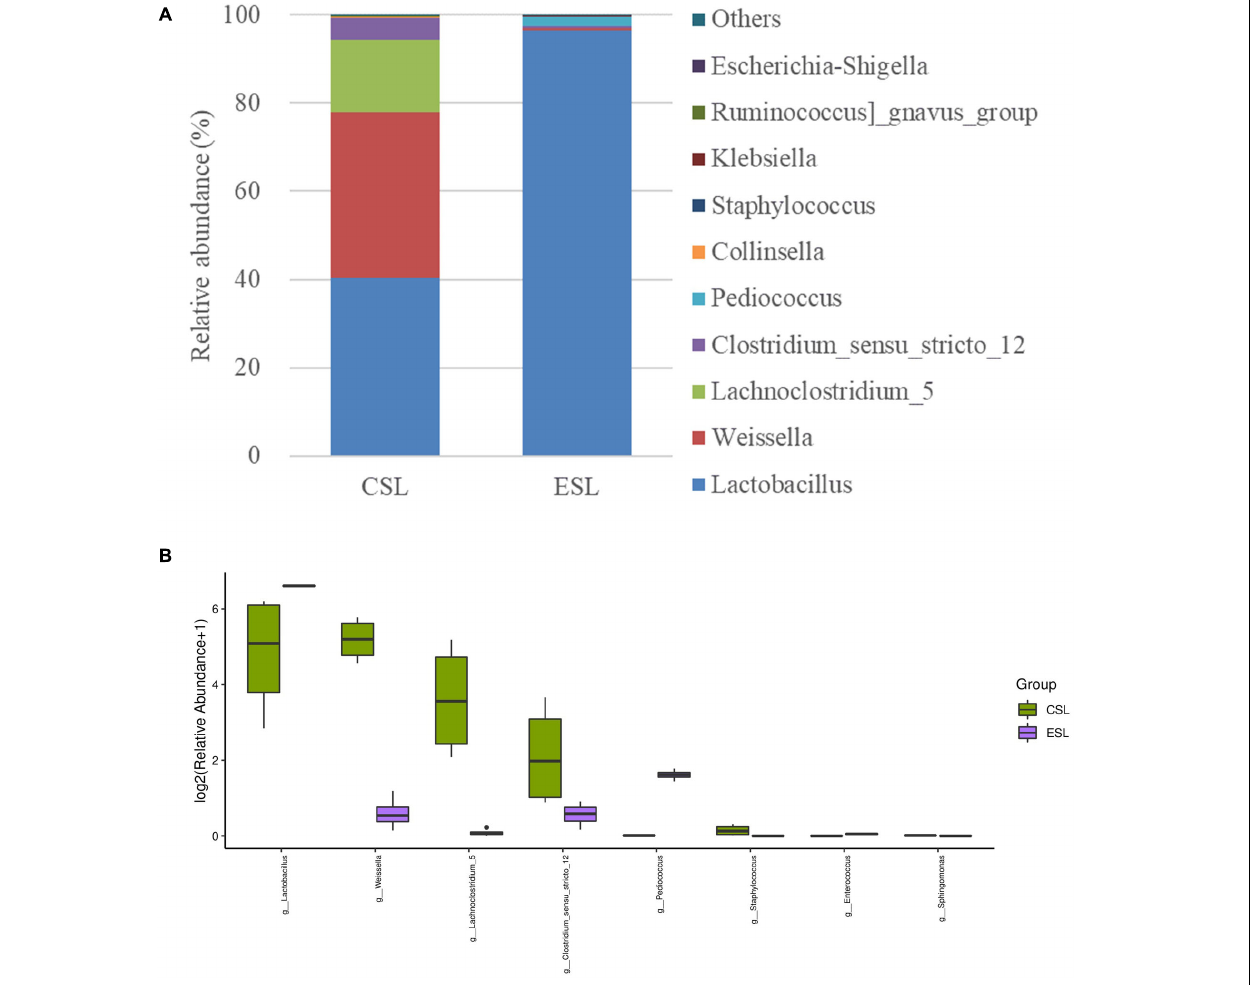
FIGURE 1 | Relative abundance of bacterial communities (genus level) in lactic acid bacterial suspensions prepared from whole-plant corn silage (LAB suspension-CS) and Elymus sibiricus silage (LAB suspension-ES) (A) and difference in bacterial communities (genus level) between LAB suspension-CS and LAB suspension-ES (B)